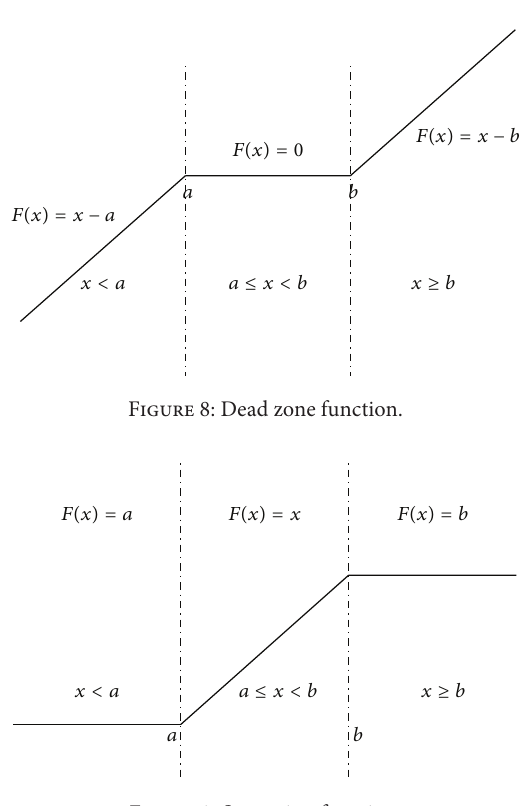
Figure 9: Saturation function.